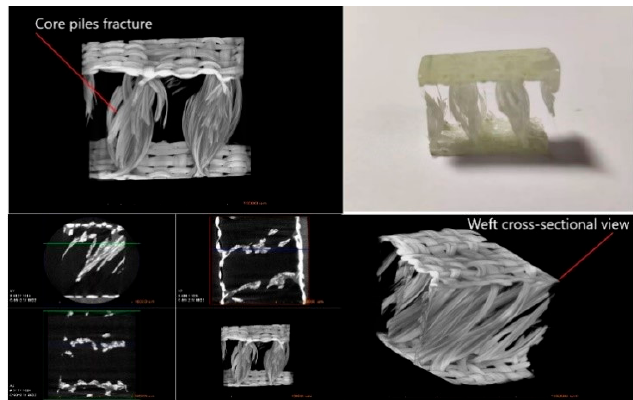
Figure 14. X-ray computed tomography images of the flexural fractured specimen.